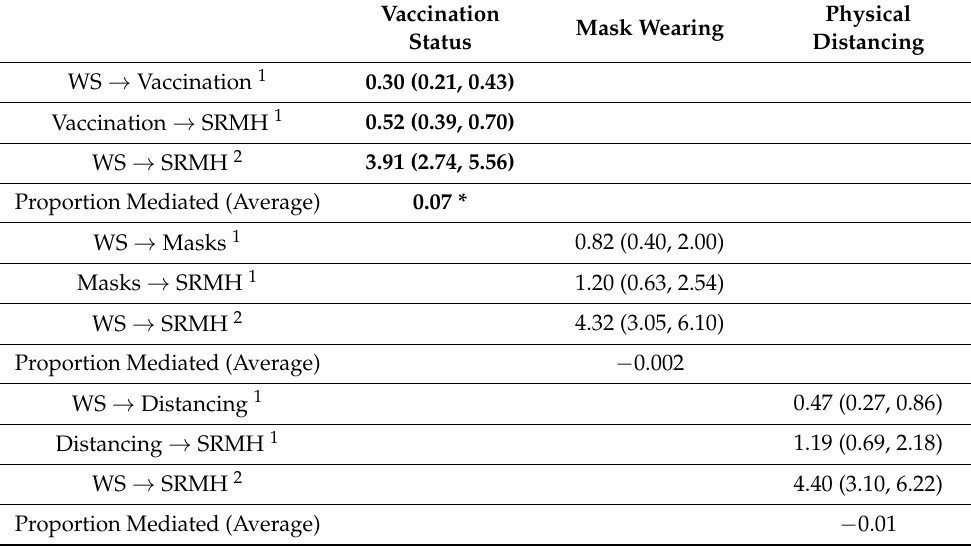
Table 3. Relationship between Work Setting (Ref = At least some of the time (Hybrid/Work from home only)), Mediators (Vaccination Status (Ref = No), Adherence to Mask Wearing Recommendations (Ref = Not at all), and Adherence to Physical Distancing Recommendations (Ref = Not at all)), and Self-Rated Mental Health (Ref =